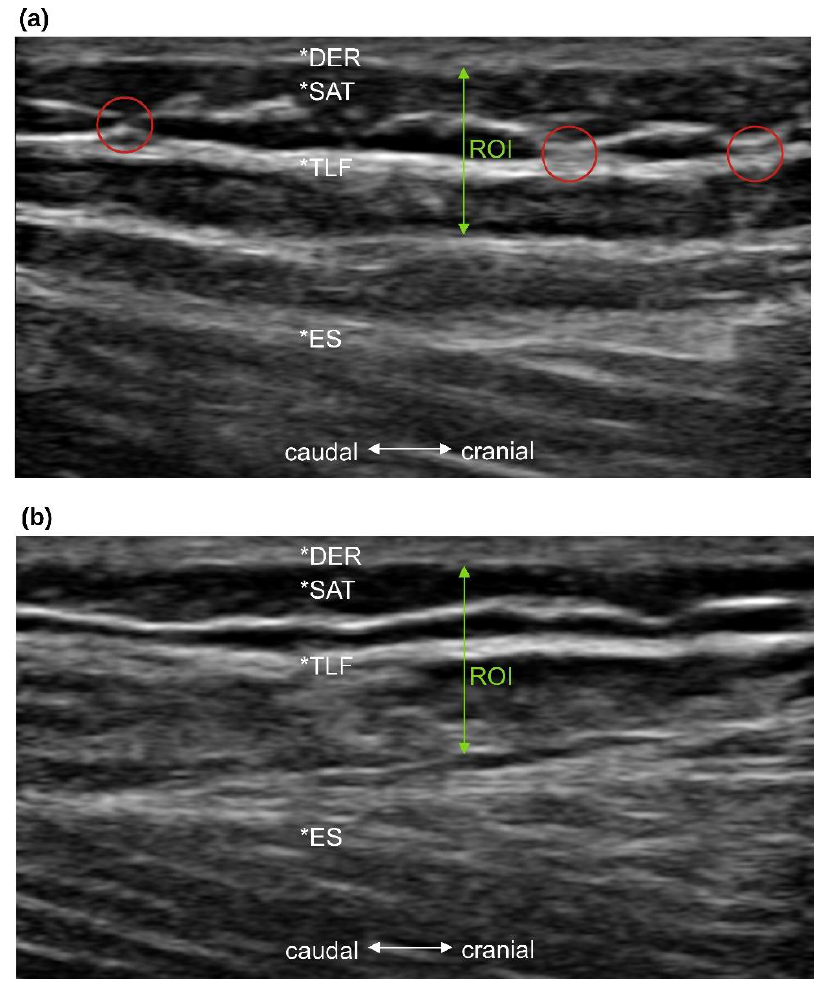
Figure 6. Thoracolumbar fascia of a patient with acute lumbar back pain. The red circles show adhesions 24 h after the lumbago, likely causing the posterior layer to take on an undulating shape that was classified as “ somewhat disorganized ” ( a ). 10 days after myofascial release treatment, the adhesions disappeared and the pain subsided completely. The fascia was then rated as “ very organized ” ( b ). *DER, dermis; *SAT, subcutaneous adipose tissue; *TFL, thoracolumbar fascia; *ES, erector spinae; ROI, region of interest, zones rated.